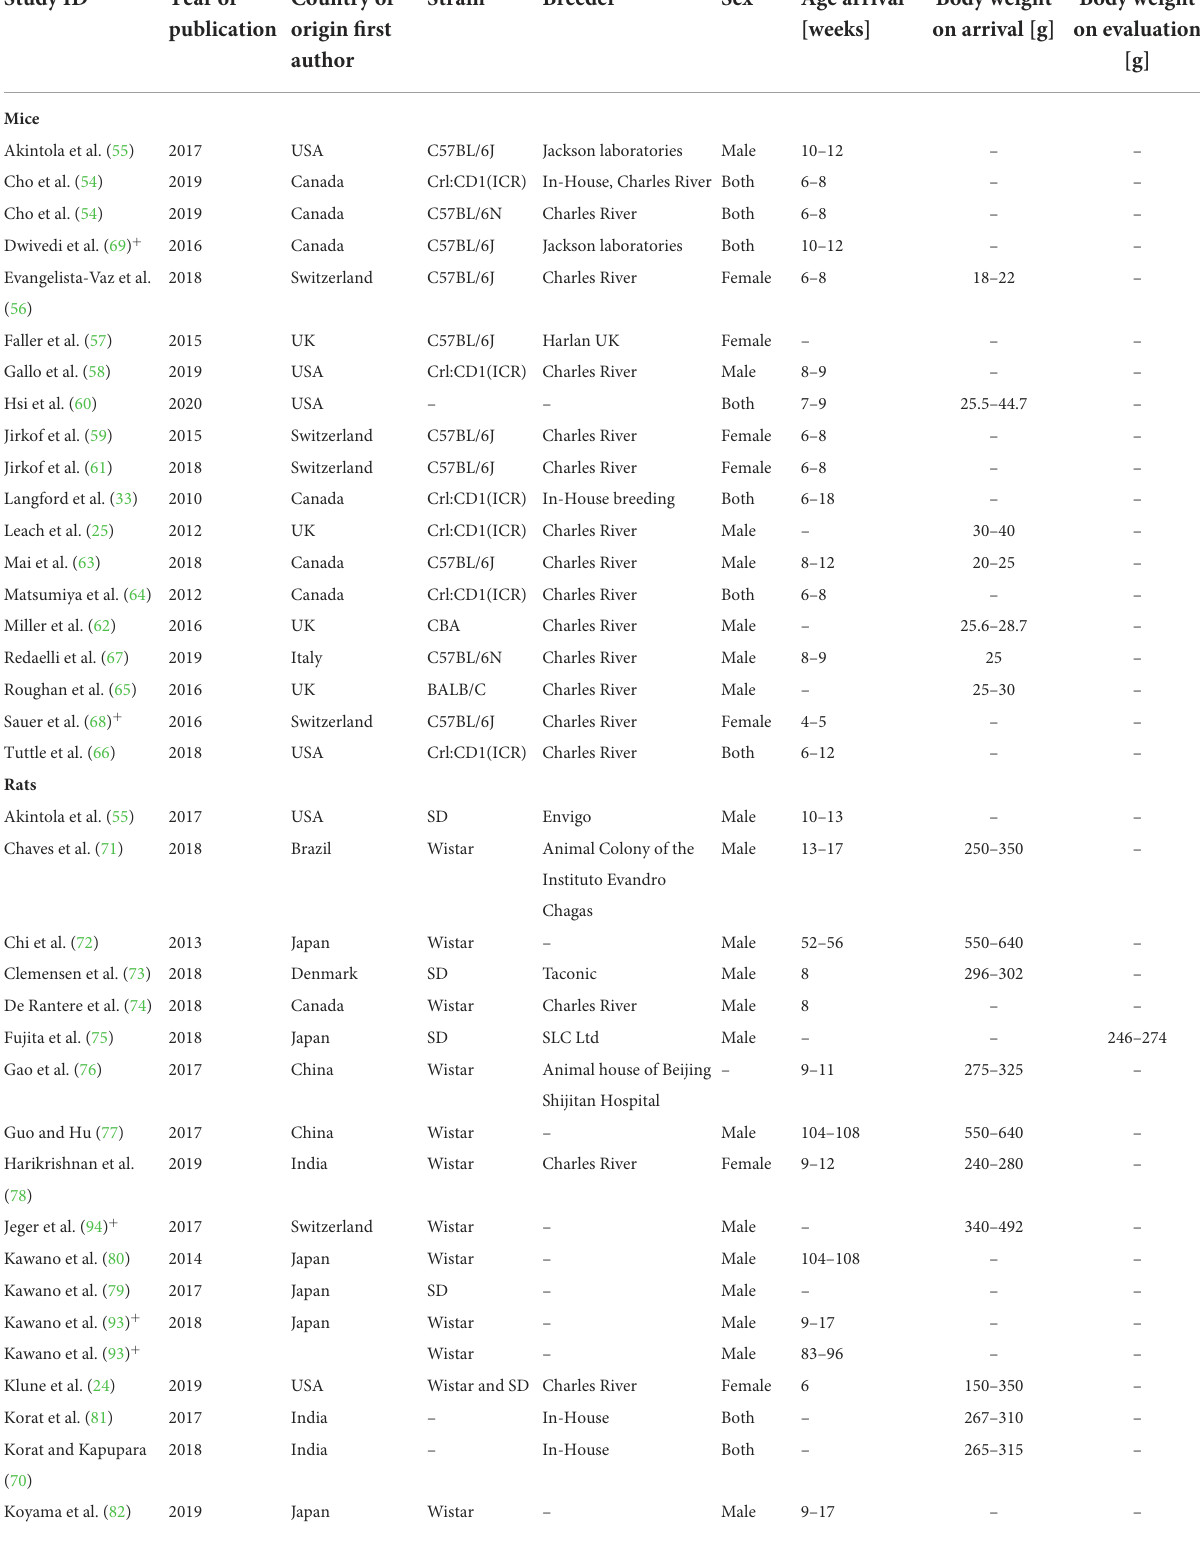
TABLE 3 Study characteristics and animal characteristics for Mouse Grimace Scale (k = 18 studies) and Rat Grimace Scale (k = 29